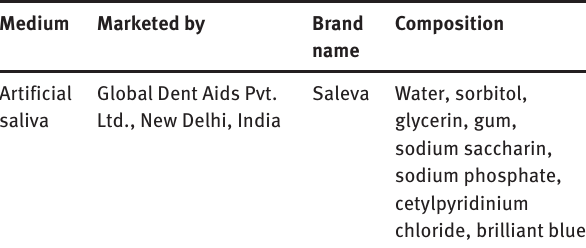
Table 3: Medium used for wear analysis in the present study.